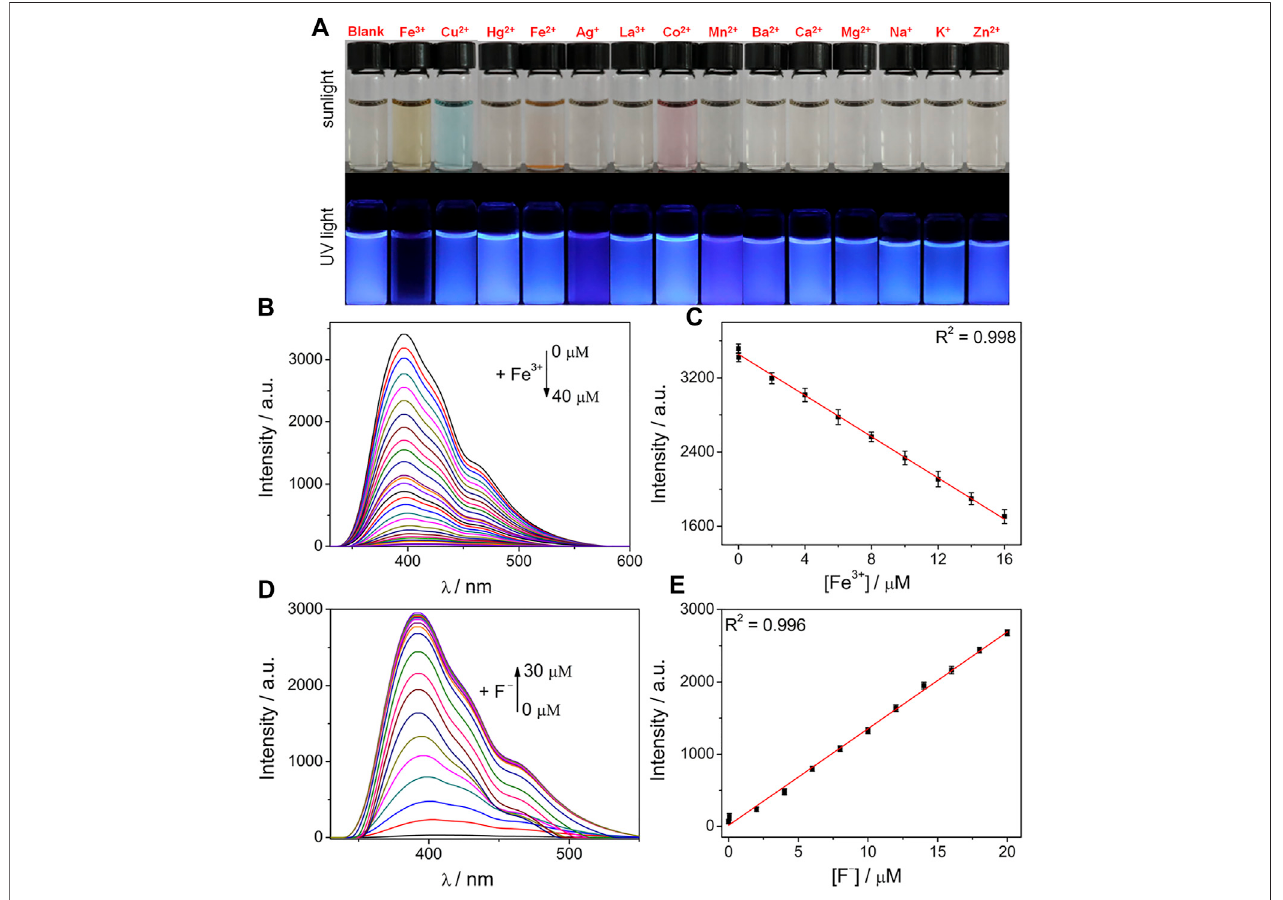
FIGURE 3 | (A) Photograph of N/P CDs (10 μ g · mL − 1 ) mixed with various metal ions (40 μ M each) under sunlight and UV light. (B) Fluorescence response of N/P CDs (10 μ g · mL − 1 ) upon addition of various concentrations of Fe 3+ (0 – 40 μ M). (C) Initial linear responses of the fl uorescence intensity to low Fe 3+ concentration (0.01 – 16 μ M). (D) Fluorescence spectraofN/P CDs(10 μ g · mL − 1 )inthepresence ofFe 3+ (40 μ M)and variousF − concentrations(0 – 30 μ M). (E) Linear relationshipofthe fl uorescence intensity versus F − concentration (0 – 20 μ